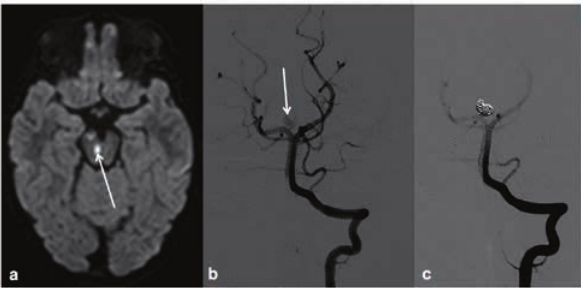
Figure 1: Unusual case of a three year old girl with an incidentally found partially thrombosed intracranial aneurysm. The girl presen- ted with oculomotoric palsies due to small brain stem and mesence- phalic (arrow) infarctions found in diffusion weighted MRI (a). Digital subtraction angiography with injection of the left vertebral artery shows the aneurysm of the right proximal posterior cerebral artery (arrow) prior (b) and after (c) endovascular occlusion with platinum